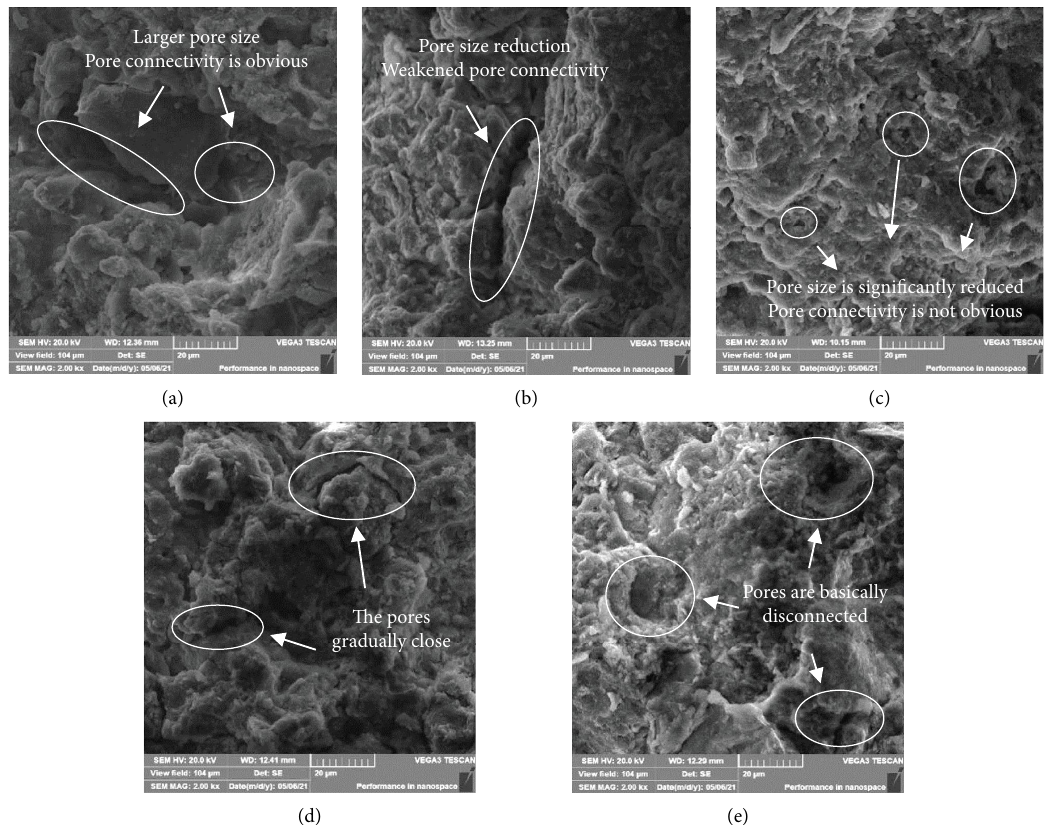
Figure 12: SEM images of samples soaked in FA solution with diferent pH values ( × 2000): (a) distilled water, (b) 6.0 pH value, (c) 5.5 pH value, (d) 5.0 pH value, and (e) 4.5 pH